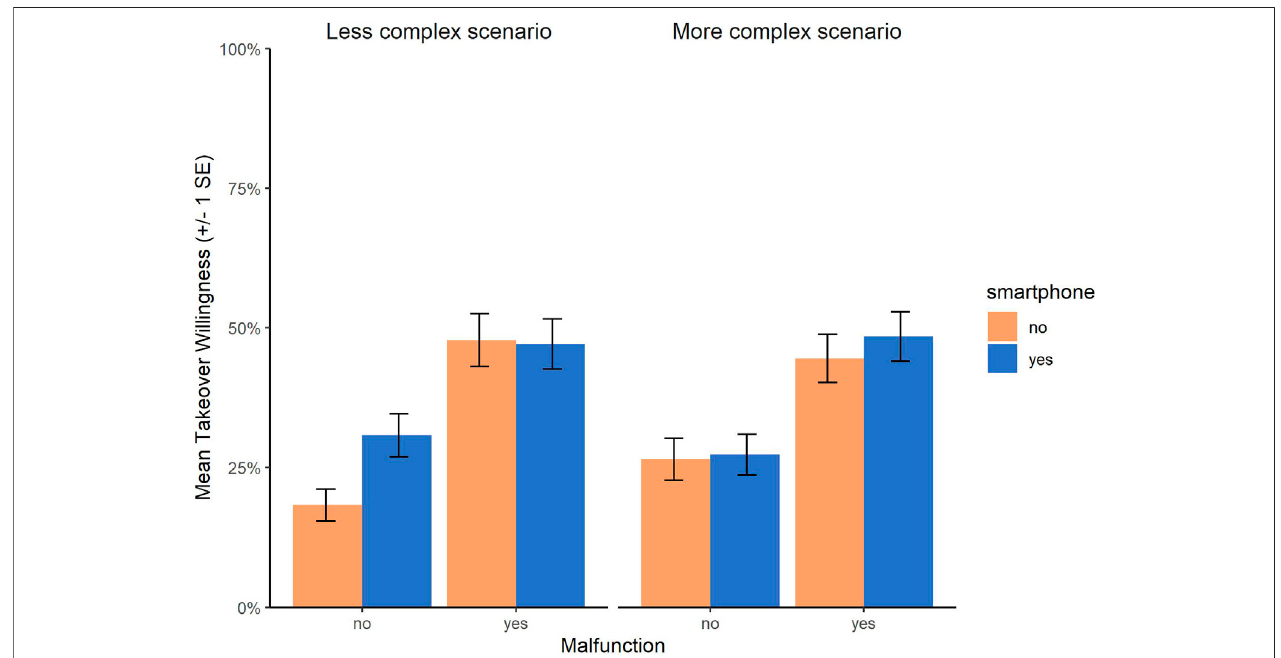
FIGURE 3 | Takeover willingness by system malfunction , crossing pedestrian ’ s smartphone use , and scenario complexity . Error bars represent standard errors. Higher ratings represent a higher willingness to take over. For results of signi fi cance tests, see text.